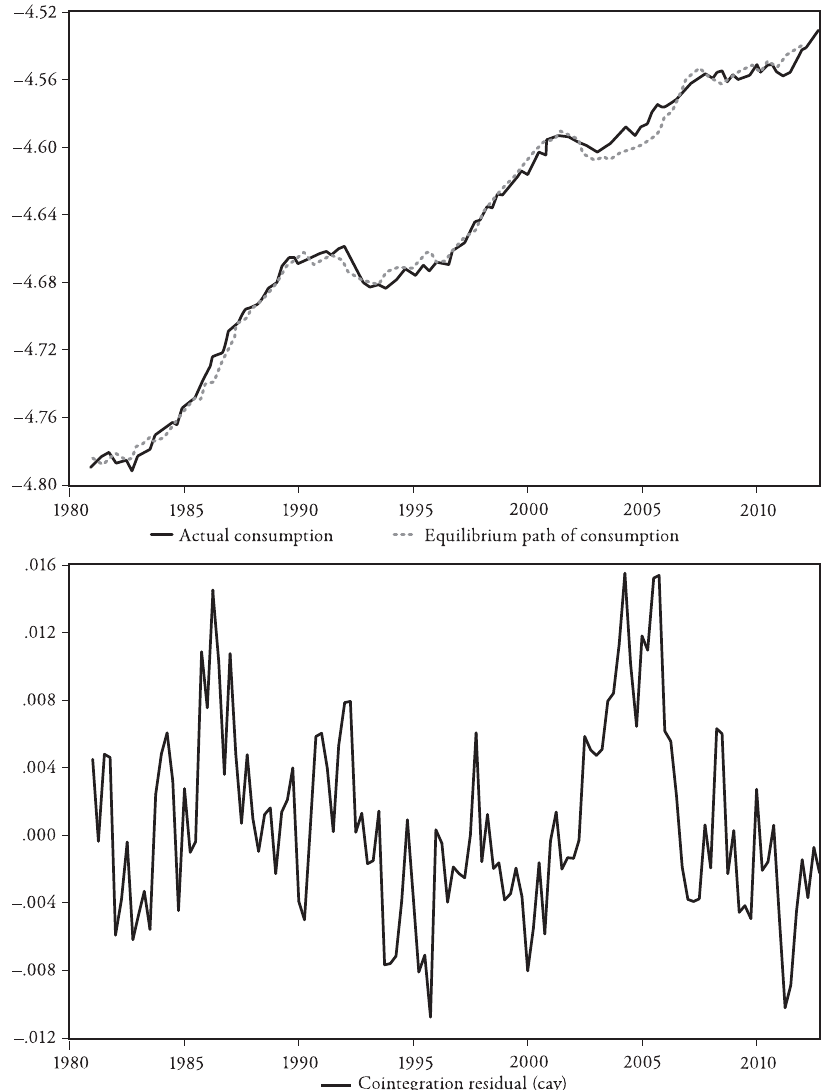
Figure 6: Equilibrium Consumption and Cay Residual from the Ba~~eline